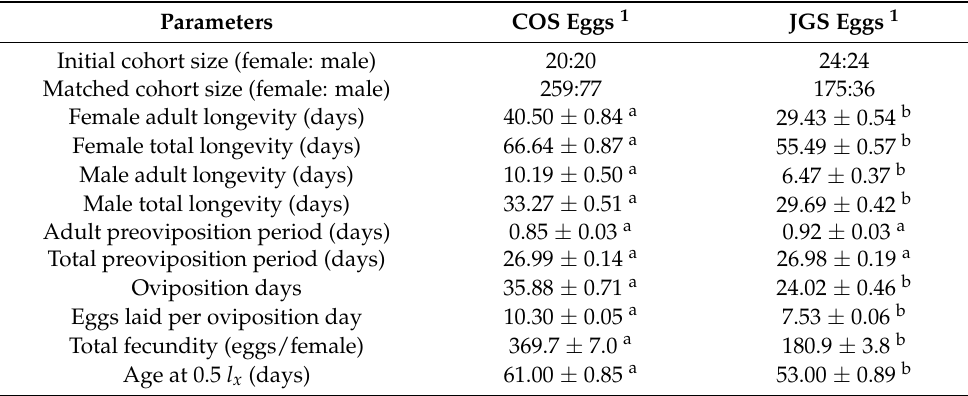
Table 1. Population cohort, adult longevity, total longevity, adult preoviposition period, total pre- oviposition period, oviposition days, eggs laid per oviposition day, fecundity, and age at 0.5 l x of A. japonicus parasitizing COS and JGS eggs.